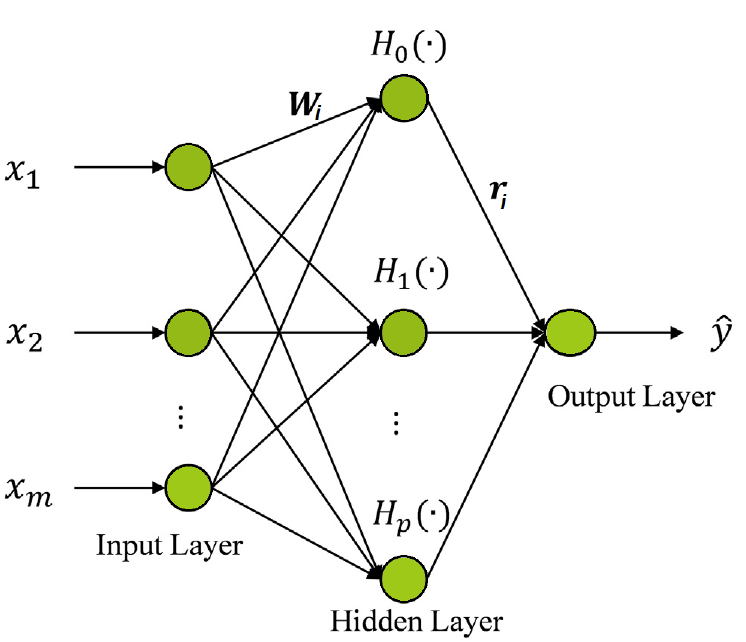
Figure 4. The structure of Hermite neural network